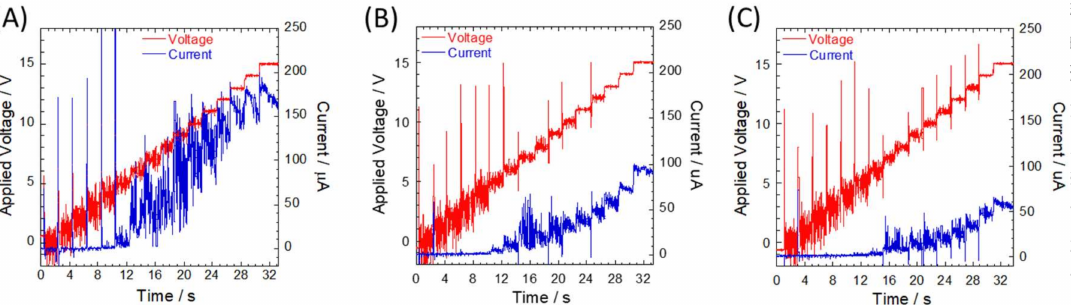
Figure 2. Representative time courses of the applied voltage (red line) and the channel currents (blue line) on the silicon microchannels with the following varying oxide layer thicknesses: ( A ) NO, ( B ) 100 nm, and ( C ) 250 nm. In all experiments, channels were filled with 1 × TBE, and applied electric fields were raised by 1 V every 2 s from 0 to 15 V. Channel currents were monitored using an ampere meter embedded in the high voltage sequencer. Current measurements were performed in two separate measurements using a single device, namely, from 0 to 7 V and from 8 to 15 V, due to limitations in the programmable voltage sequencer. Therefore, presented values are combined data from the two sets of